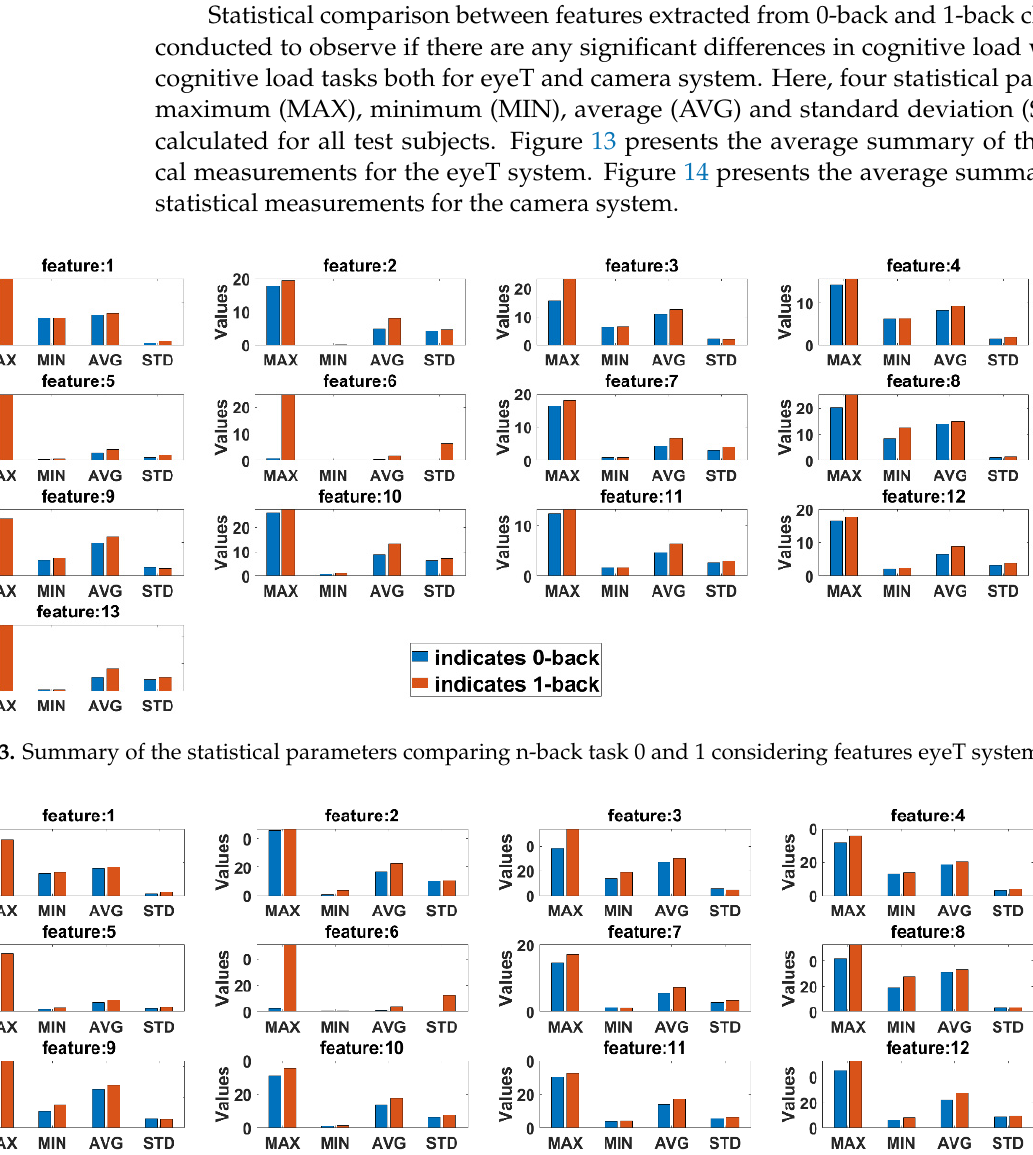
Figure 12. Correlation coefficients between the features extracted both by the eyeT and camera systems.